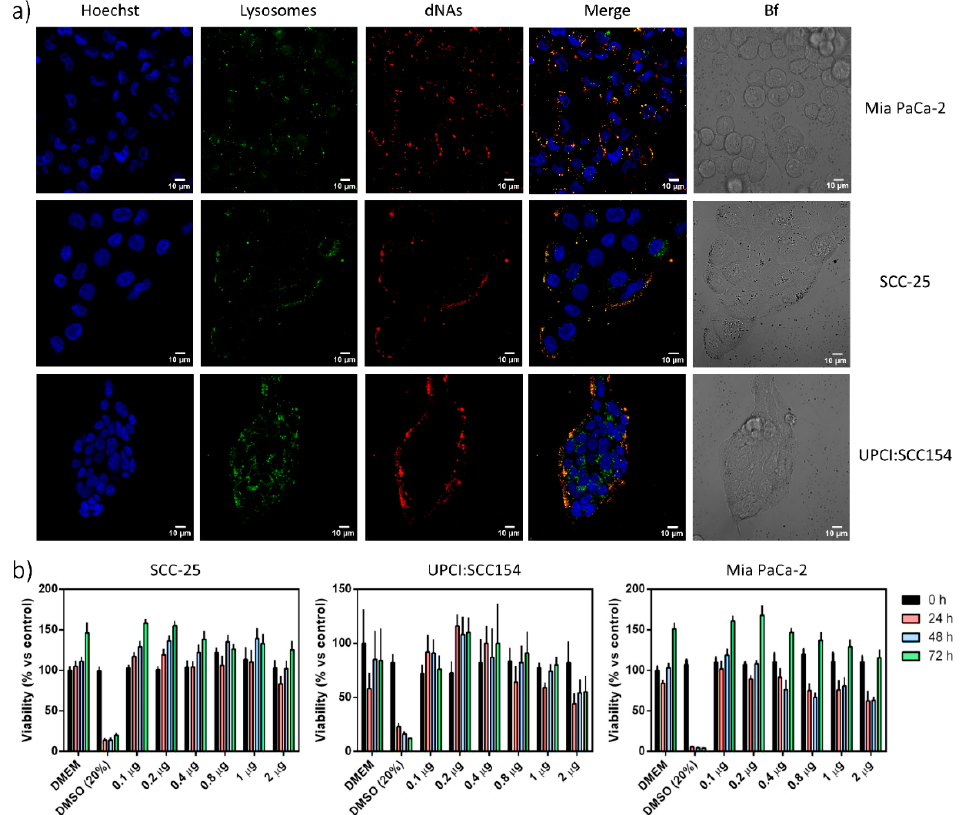
Figure 3. ( a ) Nanoparticle internalization in cells. dNAs-Alexa680 were used to treat different cell lines, and internalization was evaluated by confocal microscopy. From the left to the right column: nuclei (blue, stained with Hoechst 33342), lysosomes (green, stained with Lysotracker green DND-26), dNAs (red, labeled with Alexa-680), superimposition of nuclei, lysosomes, and nanoparticles, and finally the bright field. Scale bar: 10 μ m. ( b ) Cytotoxic effect of dNAs on different cell lines. Each cell line was treated with an increasing amount of gold that corresponded to an increasing amount of nanoparticles. Nanoparticles were incubated with cells for 2 h at 37 °C with 5% CO 2 . The viability of each cell line was measured by a WST-8 assay for 72 h after treatment and related to the viability of control cells (treated only with Dulbecco’s modified Eagle medium (DMEM)). Results are the average of three different experiments, and bars state the standard error. (Two-way ANOVA Dunnet’s multiple comparison analysis was performed).